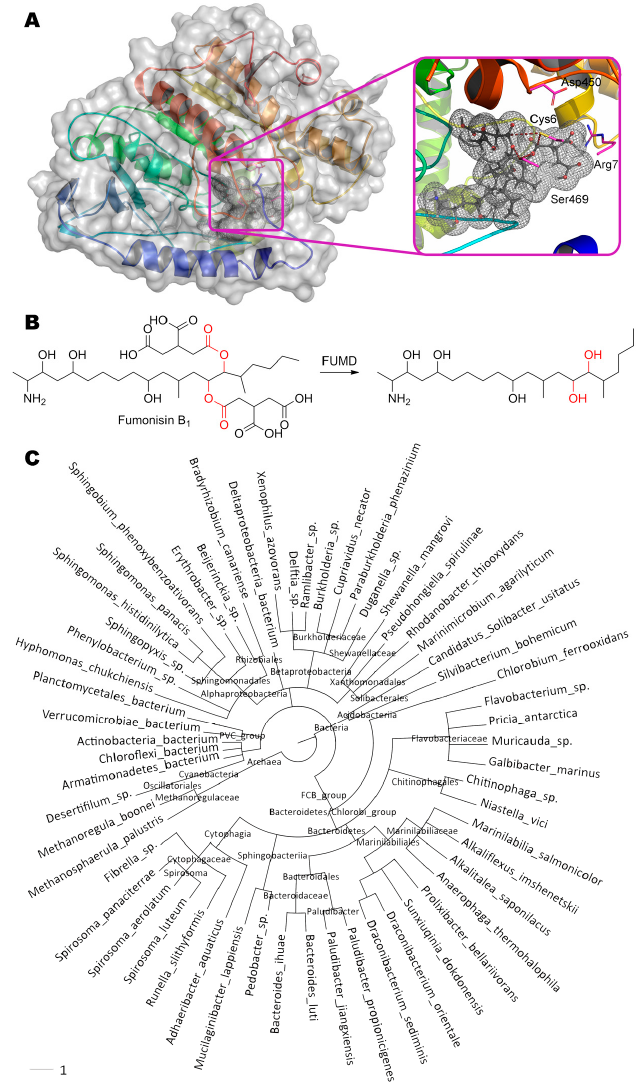
Figure 9. ( A ) Structure of enzyme FUMD containing fumonisin B 1 in its active center, and ( B ) scheme of substrate conversion with FUMD. Amino acid sequence was obtained from UniProt D2D3B6 and folded as described early. Position and geometry of substrate binding was determined as described early. ( C ) Phylogenetic tree of microorganisms possessing homologous enzymes found with BLAST.